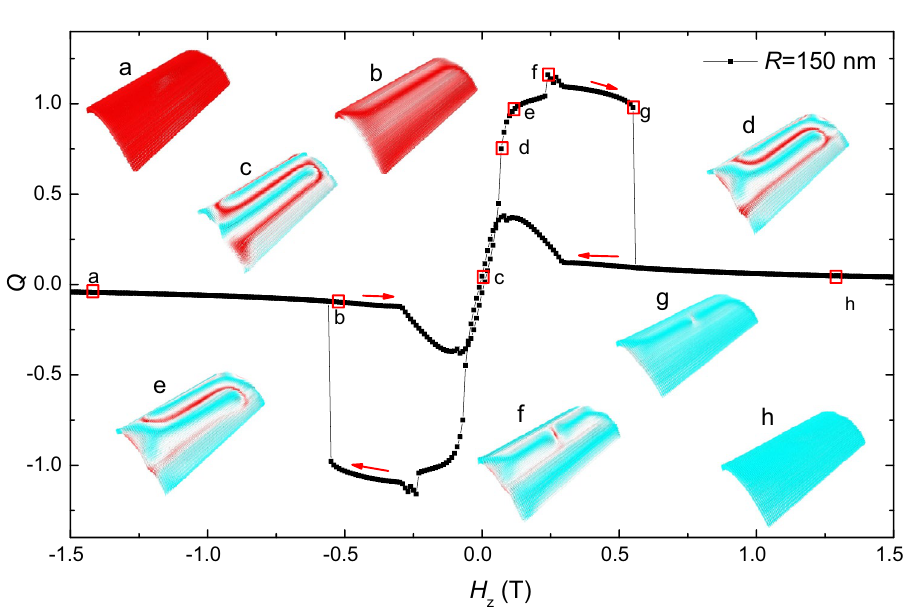
Figure 7. The topological number as a function of H z and the evolution of the magnetic structure during this process in the circular curved film with R = 150